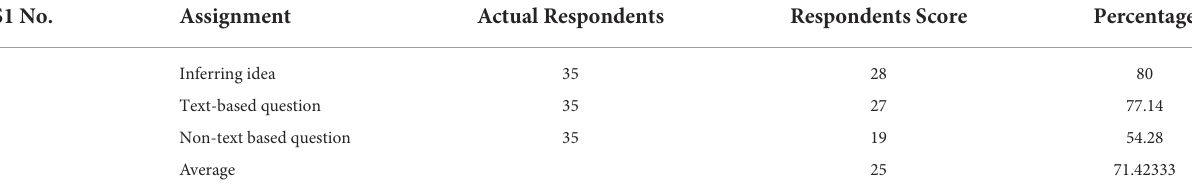
TABLE 3 Learners’ competency in discourse. S1 No.